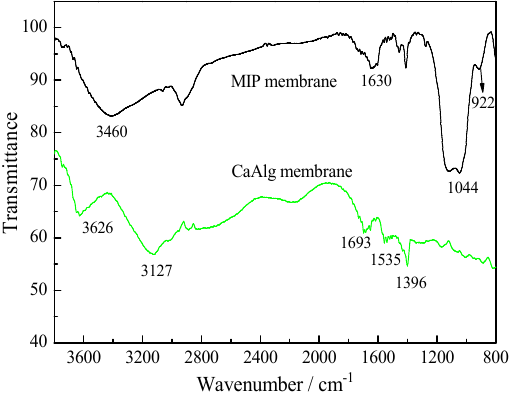
Figure 4. FT-IR spectra of CaAlg membrane and MIP membrane.